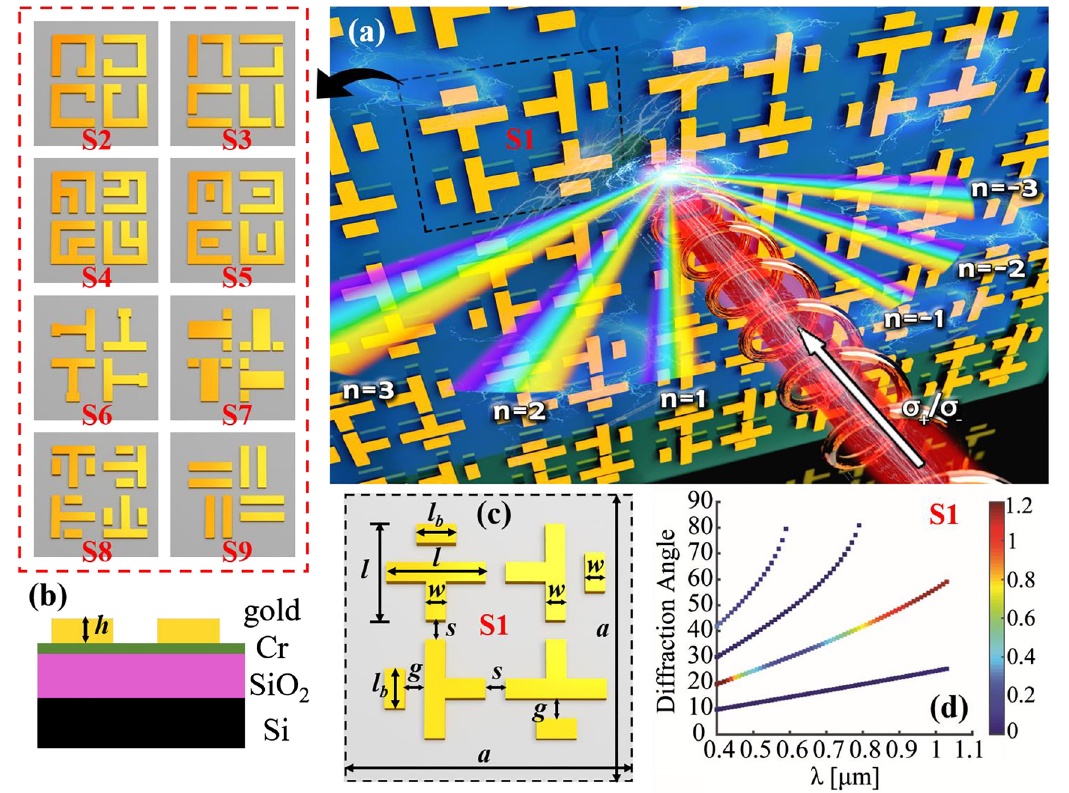
Figure 4: Optical description of various two-dimensional (2D) diffractive chiral metamaterials. (a) The right panel shows the higher-order diffraction patterns in S1 metamaterial when irradiated by the circularly polarized light. Notably, shapes of the metallic array can be changed to other eight structures shown on the left, referred as S2 – S9. (b) The depth profile for S1 – S9 chiral metamaterials: the thickness of gold, Cr, and SiO 2 fi lms is h = 30, 10, 200 nm, respectively, with Si layer to be the substrate. (c) The geometric illustration for S1 metamaterials, which contains a length of l, a width of w, a separation between two adjacent modules of s, a gap length of g, and a bridge length of lb. (d) The rigorous coupled wave analysis (RCWA)-calculated normalized intensities for the n = 1 – 4 diffraction order beams in S1 metamaterial, under left circularly polarized (LCP) light